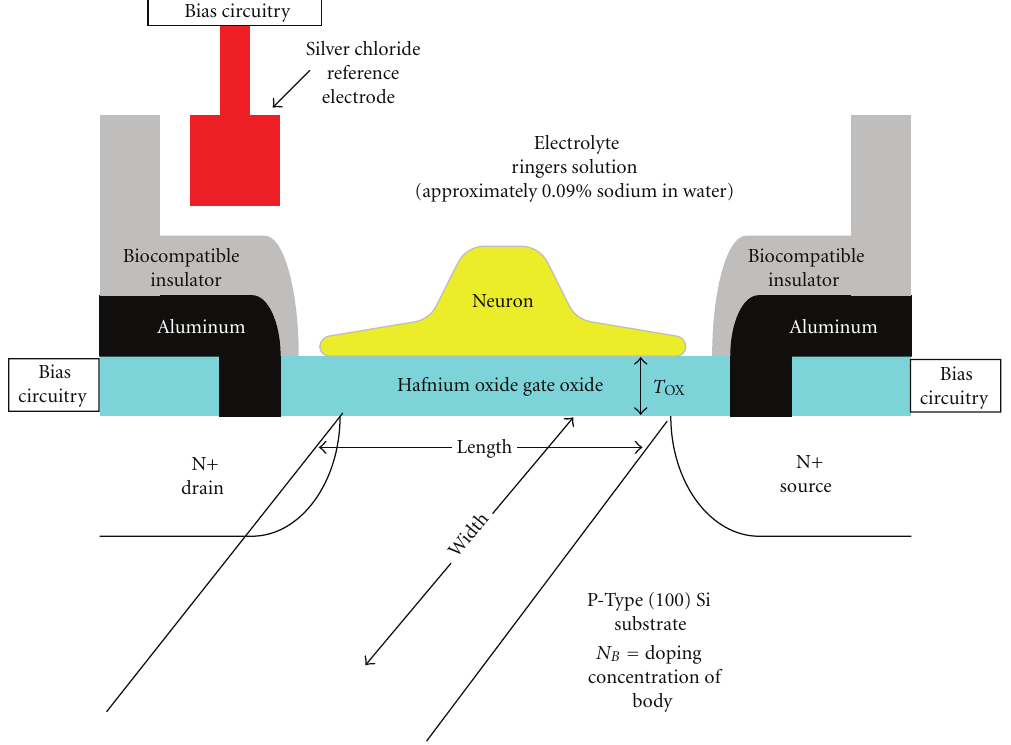
Figure 1: Neuron-FET cross-section. Modified from